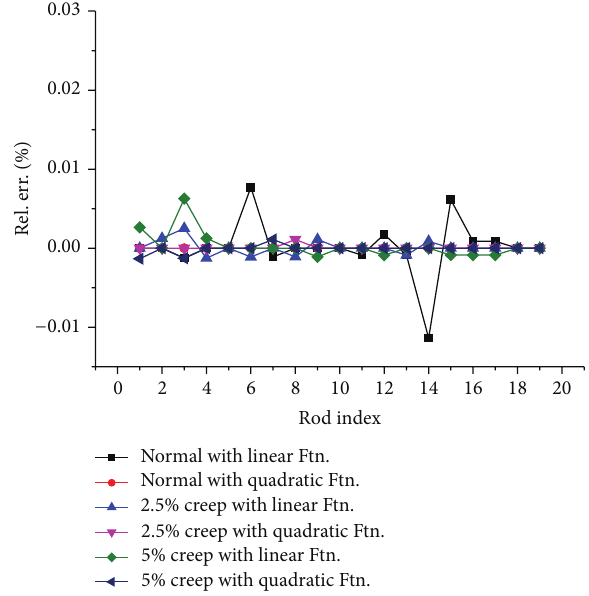
Figure 5: Relative pin power errors with different BCs of the TRIAINA-SP3